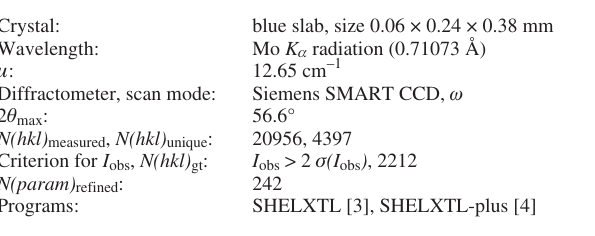
Table 1. Data collection and handling.